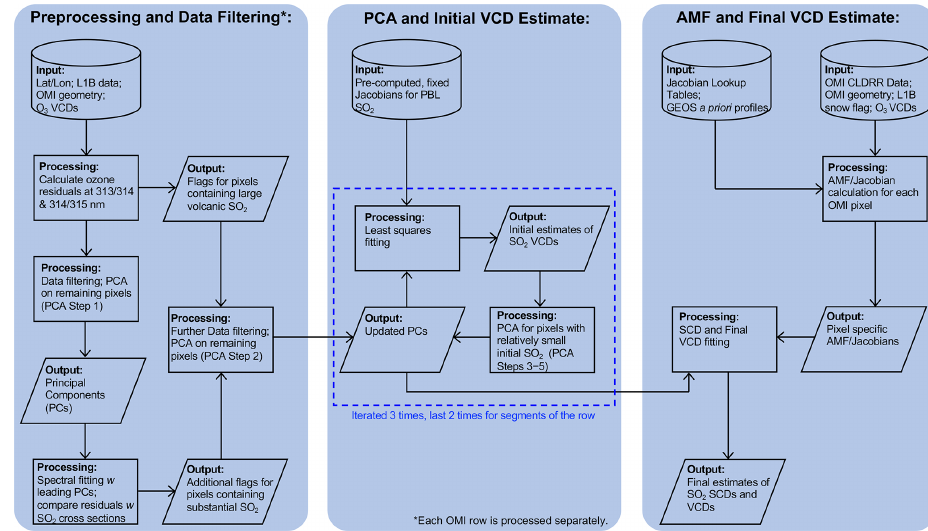
Figure 1. Flowchart of the PCA-based spectral fitting algorithm for the anthropogenic SO 2 dataset in the OMSO2 V2